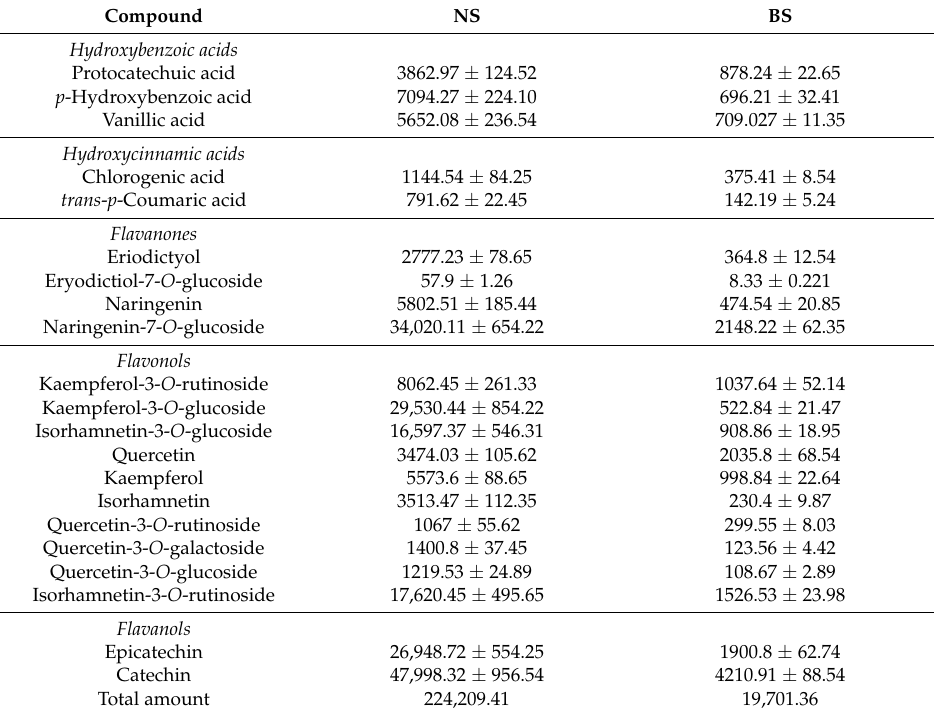
Bold values correspond to the peak number present in the chromatograms. * RT = Retention time. Table 3. Polyphenolic compounds in natural (NS) and blanched (BS) almond skins. Values are expressed as µ g/100 g and represent the average ( ± SD) of three independent experiments ( n =